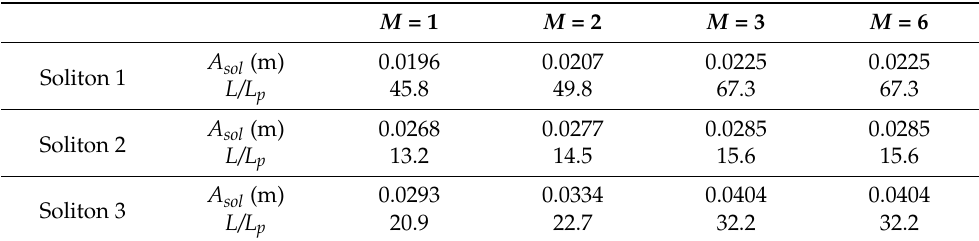
Table 2. The height and persistence distance of solitons for different nonlinear orders.